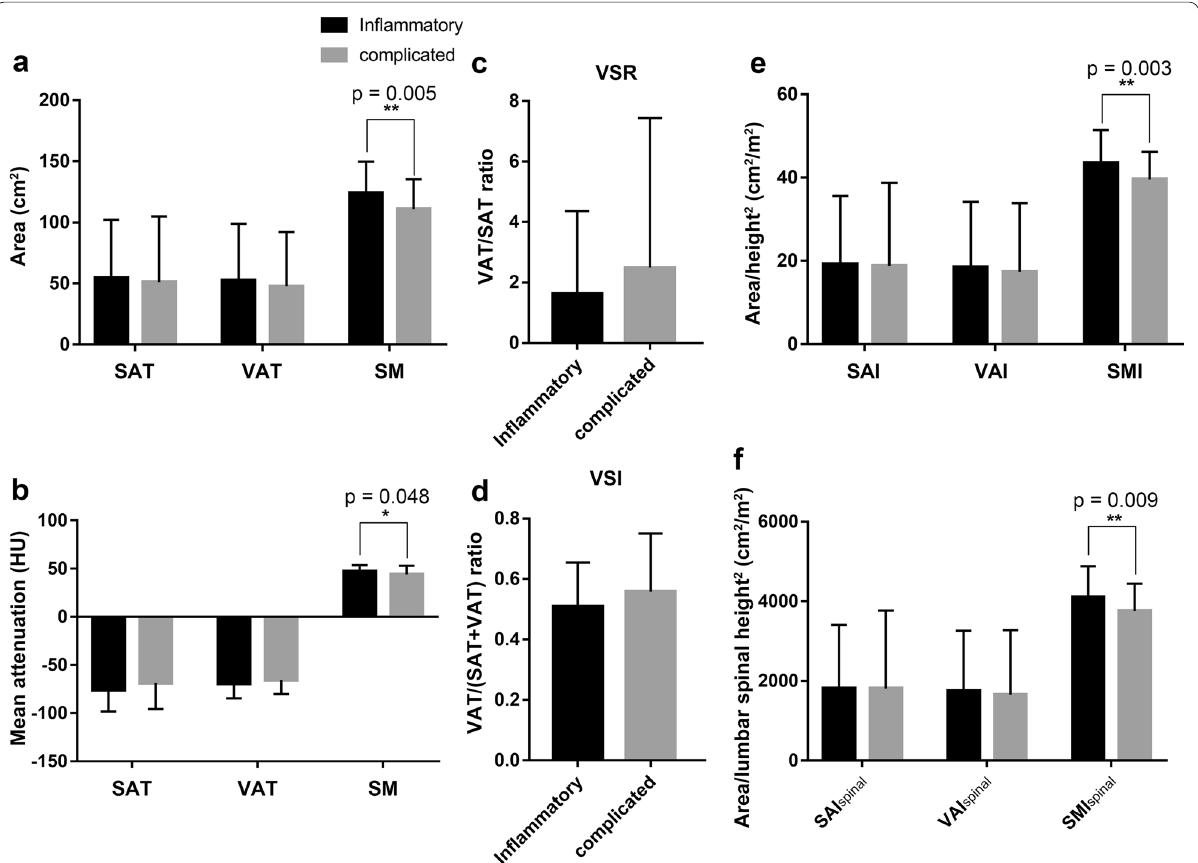
Fig. 4 Body composition in complicated and inflammatory CD. a Area of SAT, VAT, and skeletal muscle in complicated and inflammatory CD; b mean attenuation of SAT, VAT, and skeletal muscle in complicated and inflammatory CD; c VSR in complicated and inflammatory CD; d VSI in complicated and inflammatory CD; e Value of SAI, VAI, and SMI in complicated and inflammatory CD; f Value of SAI spinal , VAI spinal , and SMI spinal in complicated and inflammatory CD. The data are presented as means SD, p values by two-tailed unpaired t tests. SAT subcutaneous adipose tissue, ± VAT visceral adipose tissue, VSR area of visceral fat/area of subcutaneous fat, VSI area of visceral fat/(area of visceral fat area of subcutaneous fat), +